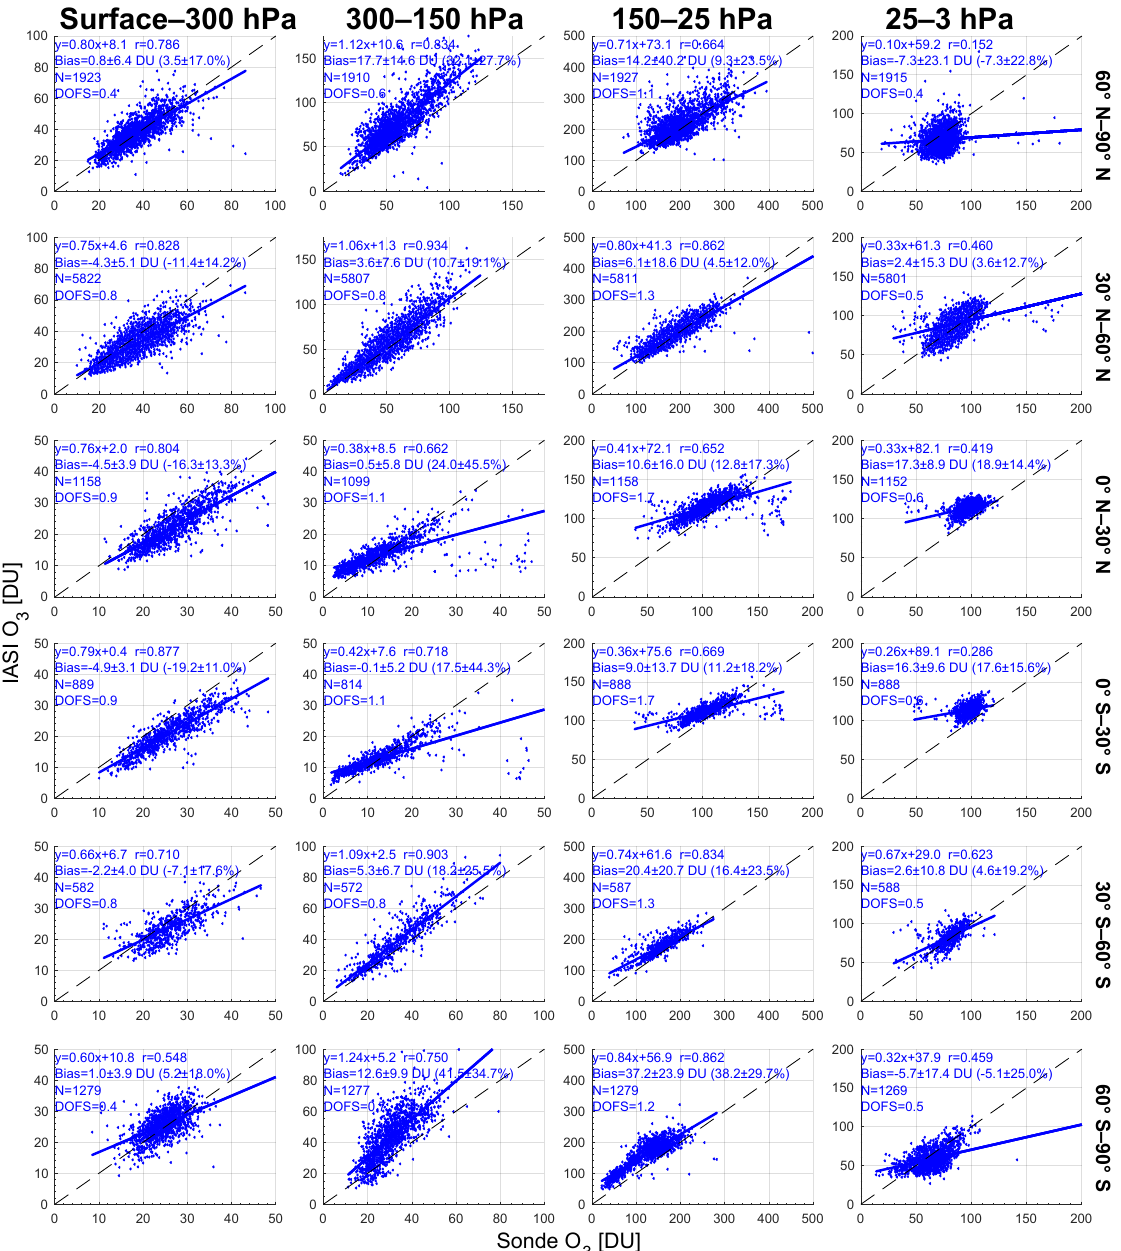
Figure 14. Scatterplots of collocated IASI-A and smoothed ozonesonde O 3 partial columns for six latitude bands for the period from 2008 to 2017. Comparison statistics including the linear regression, the mean bias, the 1 σ standard deviation in both Dobson units (DU) and percent (%), the number of collocations and the mean DOFS for each partial column are shown on each